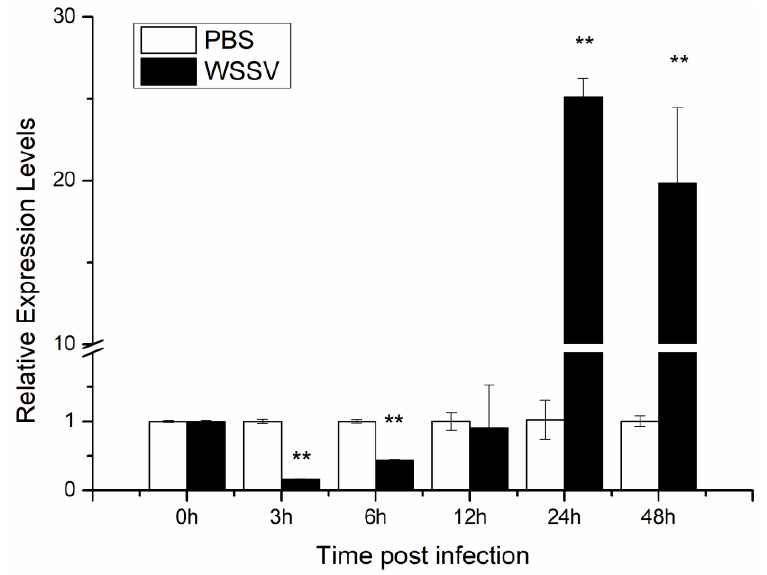
Figure 5. Expression levels of LvHSSP in hemocytes of shrimp at different time post-WSSV challenge. PBS stands for PBS injection group, and WSSV stands for WSSV injection group. Stars (**) indicate extremely significant difference ( p < 0.01) in the gene expression levels between the two treatments. All assays described above were biologically repeated three times.